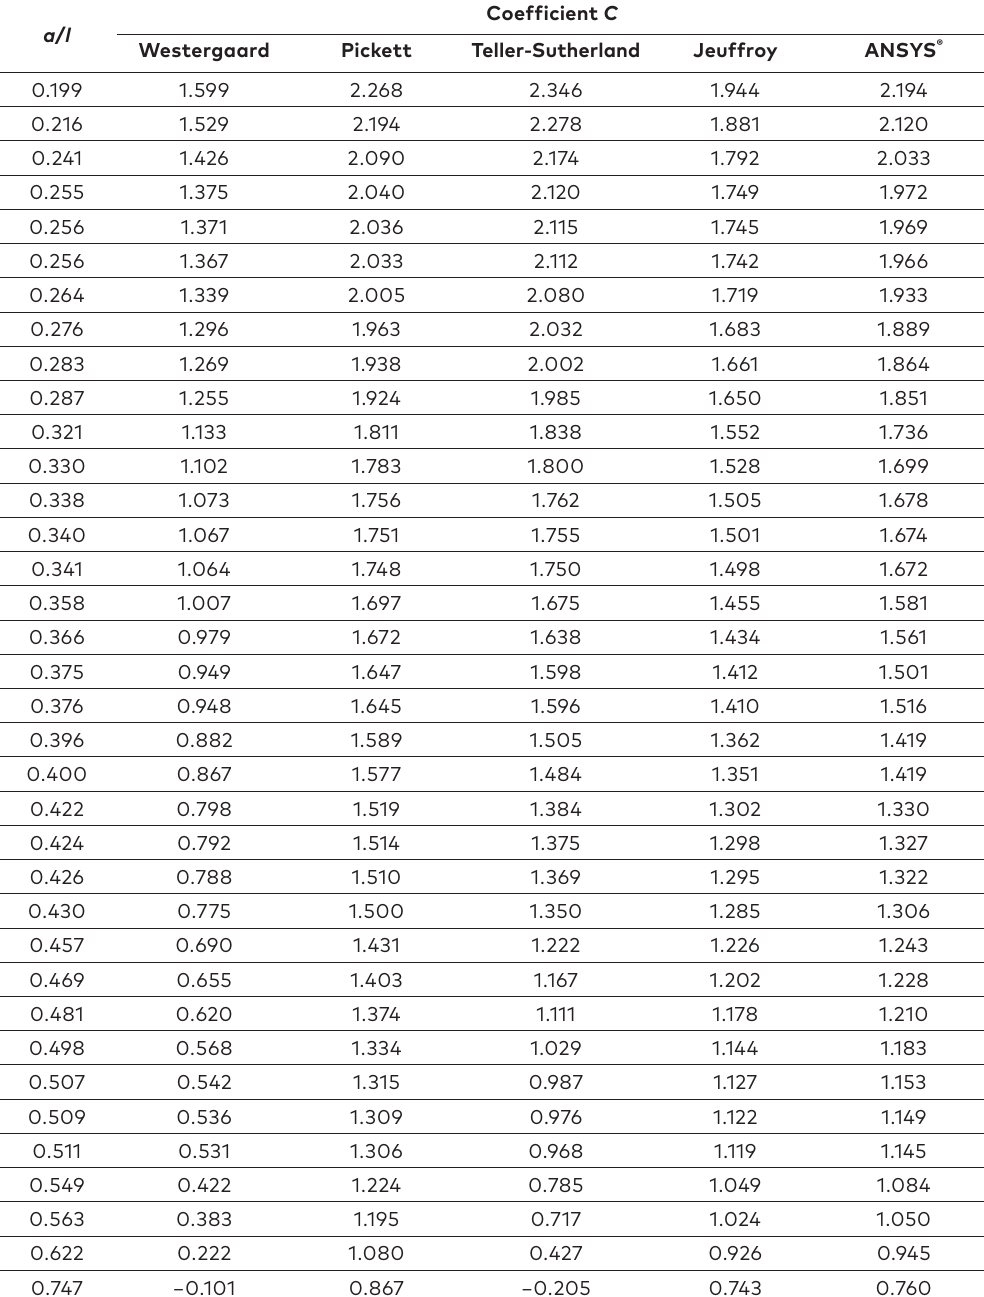
Table 2. C values obtained varying the ratio a /